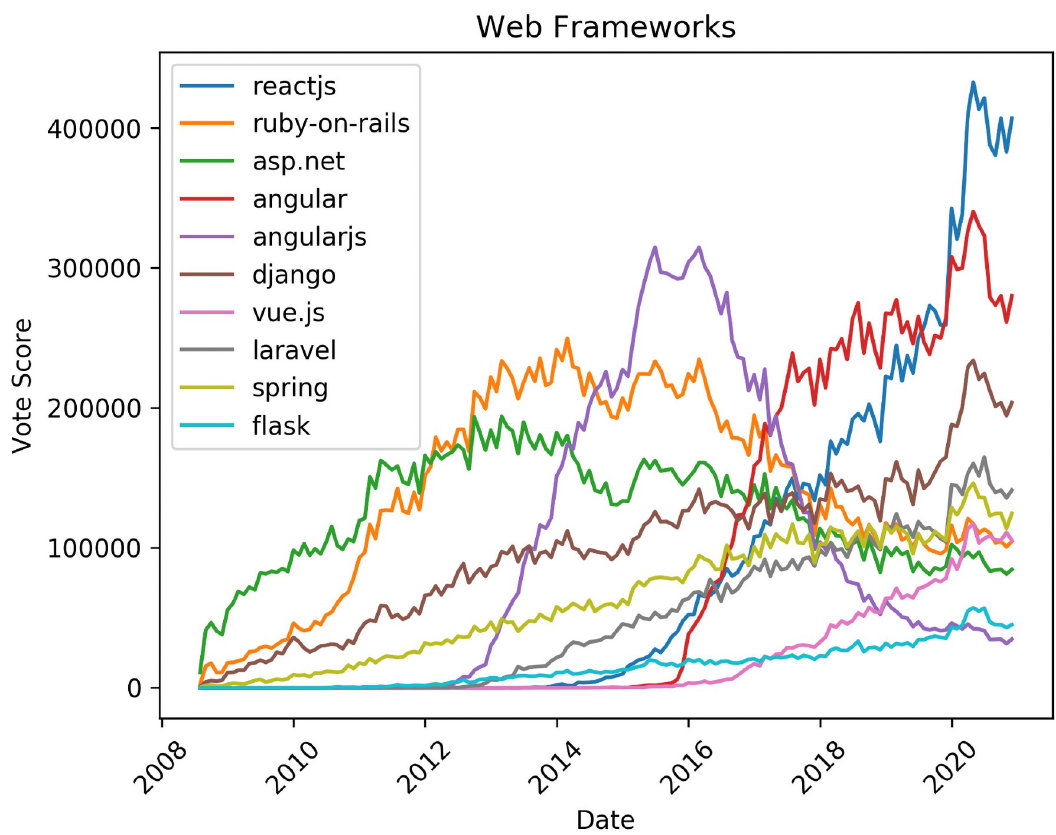
Fig 3. Trends in tag popularity: Web programming